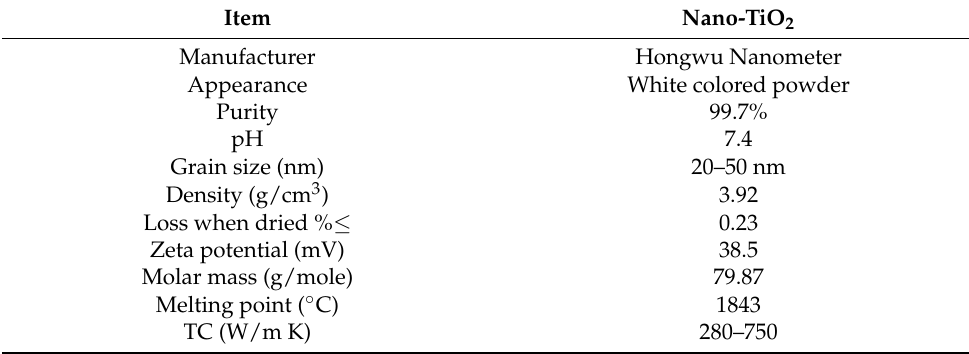
Table 3. Nano-TiO 2 specifications.